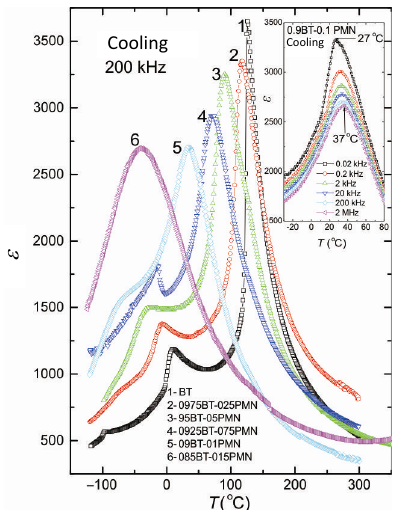
Fig. 3 Temperature evolution of the electric permittivity  of (1  x )BT– x PMN ceramics on cooling. Inset is the temperature/frequency dependence of  of 0.9BT– 0.1PMN ceramic showing relaxor